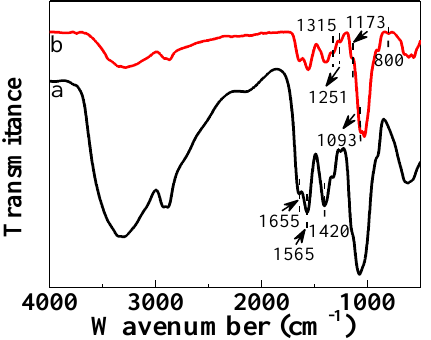
Figure 3. FTIR spectra of CS ( a ) and F-CS ( b ) aerogels .